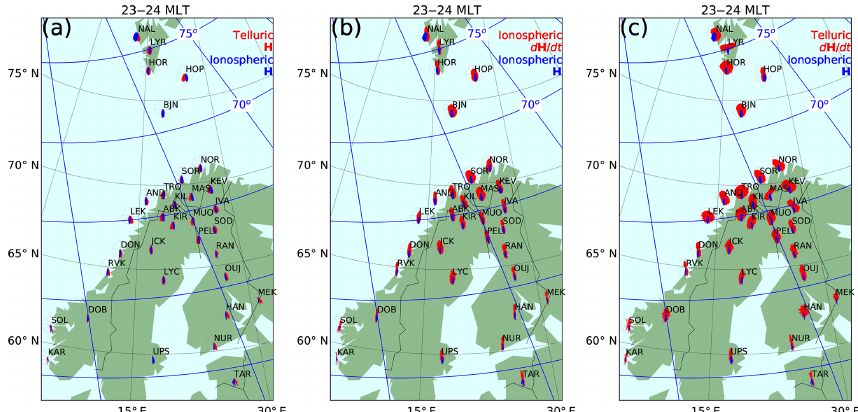
Figure 8. Histograms of the direction of the ionospheric (blue) and telluric (red) horizontal ground magnetic field, when d H/ d t > 1nTs − 1 and 23h ≤ MLT < 24h, for IMAGE stations with sufficient amounts of good data available during 1994–2018 (a) . The telluric part of the horizontal magnetic field has been replaced by the time derivative of the ionospheric part of the ground magnetic field in (b) and with the time derivative of the telluric part of the ground magnetic field in (c)